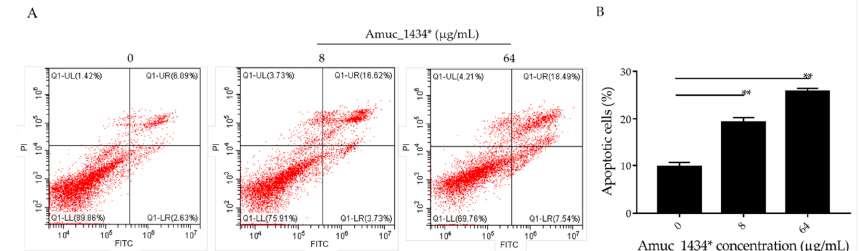
Figure 3. Amuc_1434* promoted cell apoptosis of colorectal cancer LS174T cells. ( A ) Relative cell apoptosis rate was detected via flow cytometric analysis with annexin V-FITC and PI double staining.